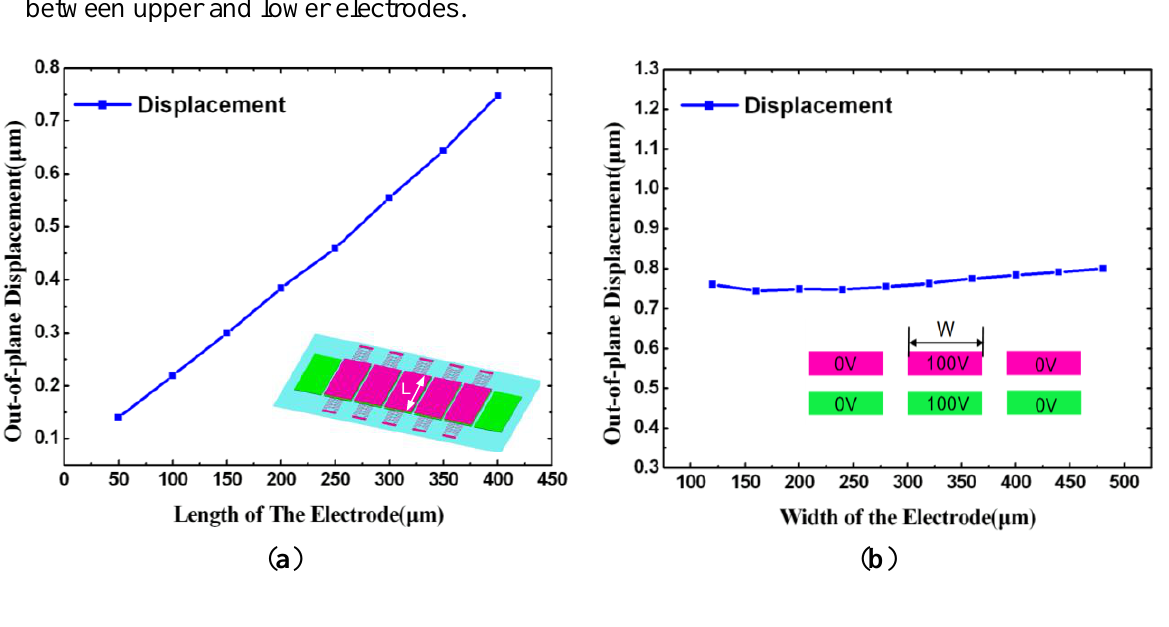
Figure 5. ( a ) Simulation results of displacement versus length of electrodes; ( b ) Simulation results of displacement versus width of electrodes; ( c ) Simulation results of displacement versus distance between electrodes; ( d ) Simulation results of displacement versus gap between upper and lower